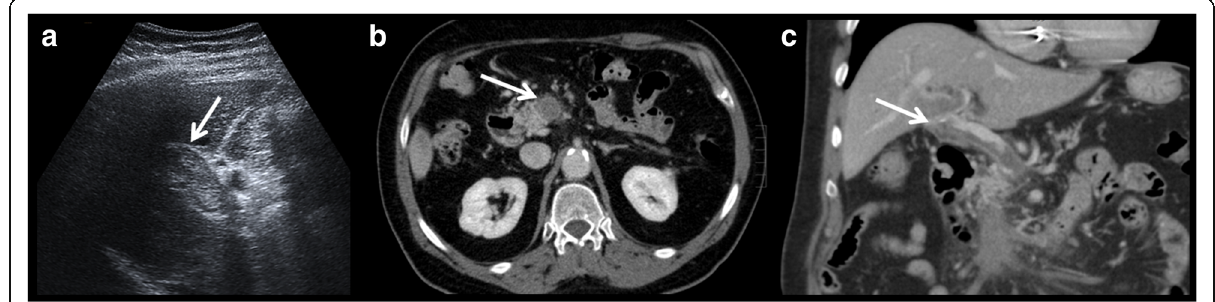
Fig. 9 Portal vein thrombosis. Echogenic material is observed on ultrasound examination ( a ). This finding is confirmed in axial CT ( b ). Multiplanar reconstructions help in the assessment of the extension ( c